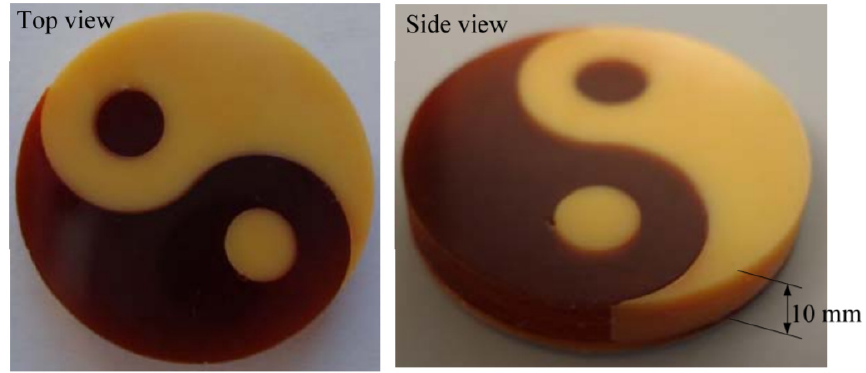
Figure 19. Test print for a multi-material DLP method using red and yellow photocurable resin (Reprinted from [116], with author permission).